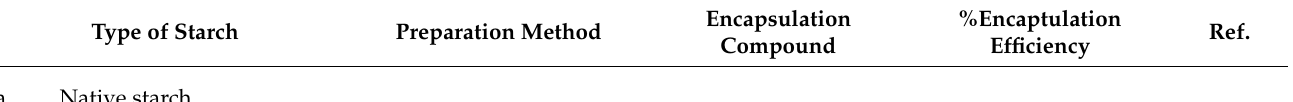
Table 7. Application of native and modified SNPs as encapsulation